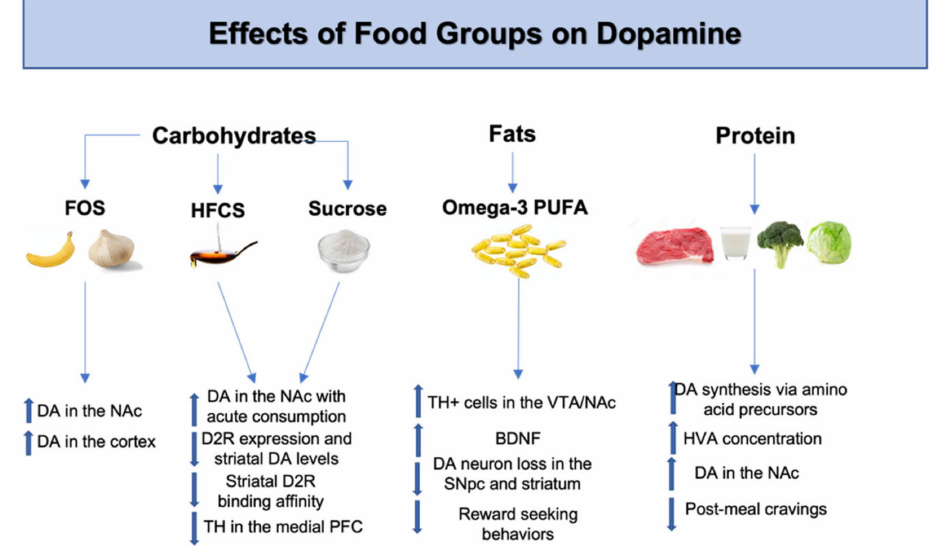
Figure 2. Effects of food groups on dopamine. FOS consumption increases dopamine levels in the NAc and the cortex [46,47]. Acute HFCS and sucrose consumption increases dopamine in the NAc [48]. Chronic HFCS and sucrose consumption decreases D2R expression, D2R binding affinity, striatal dopamine levels and TH in the medial PFC [50,52]. Omega-3 PUFA increase BDNF and TH+ cells in the VTA and NAc [57]. Omega-3 PUFA decrease dopamine neuron loss in the SNpc and striatum [58], while also reducing reward seeking behavior [59]. Protein intake increases dopamine synthesis, dopamine levels in the NAc and HVA concentrations while decreasing post- meal cravings [60–62]. Abbreviations: FOS, fructo-oligosaccharides; HFCS, high-fructose corn syrup; PUFA, poly-unsaturated fatty acids, DA, dopamine; NAc, nucleus accumbens; D2R, dopamine 2 receptor; TH, tyrosine hydroxylase; PFC, pre-frontal cortex; BDNF, brain derived neurotrophic factor; VTA, ventral tegmental area; SNpc, substantia nigra pars compacta; HVA, homovanillic